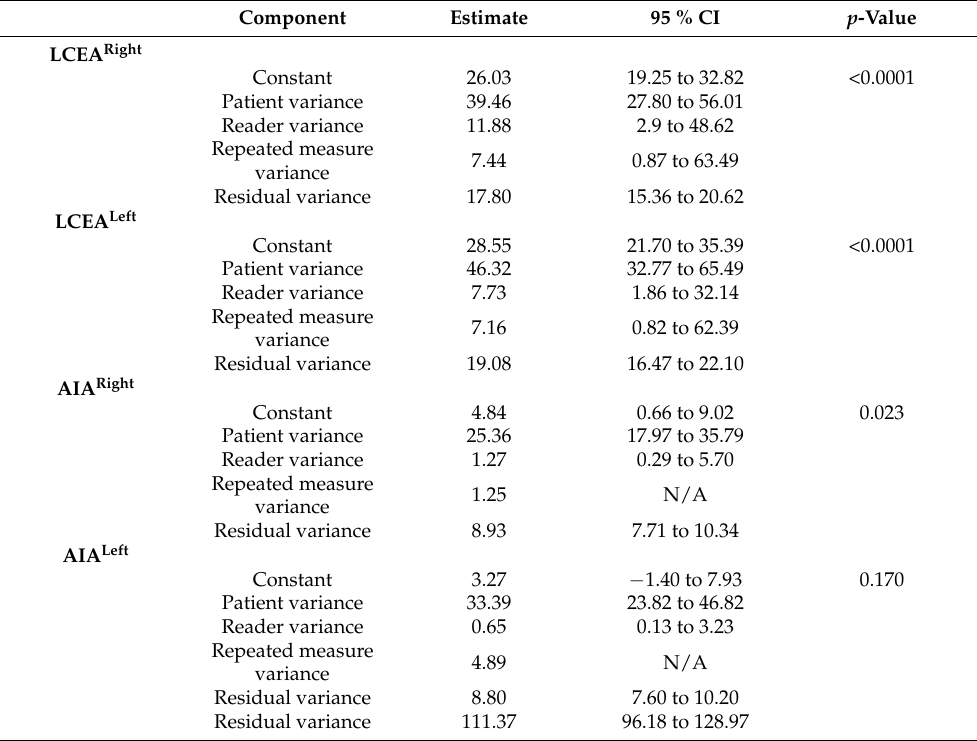
Table 5. Estimated variances derived from the linear effects model. Five human readers, LCEA and AIA. (n = 78).